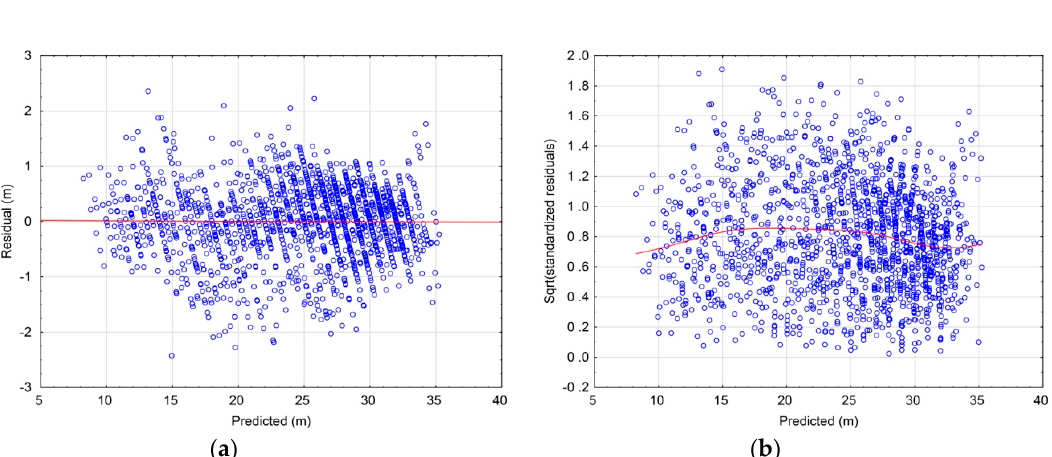
Figure 3. Plot of residuals against the predicted values of top height fitted by the model ( a ) and scale-location ( b ).